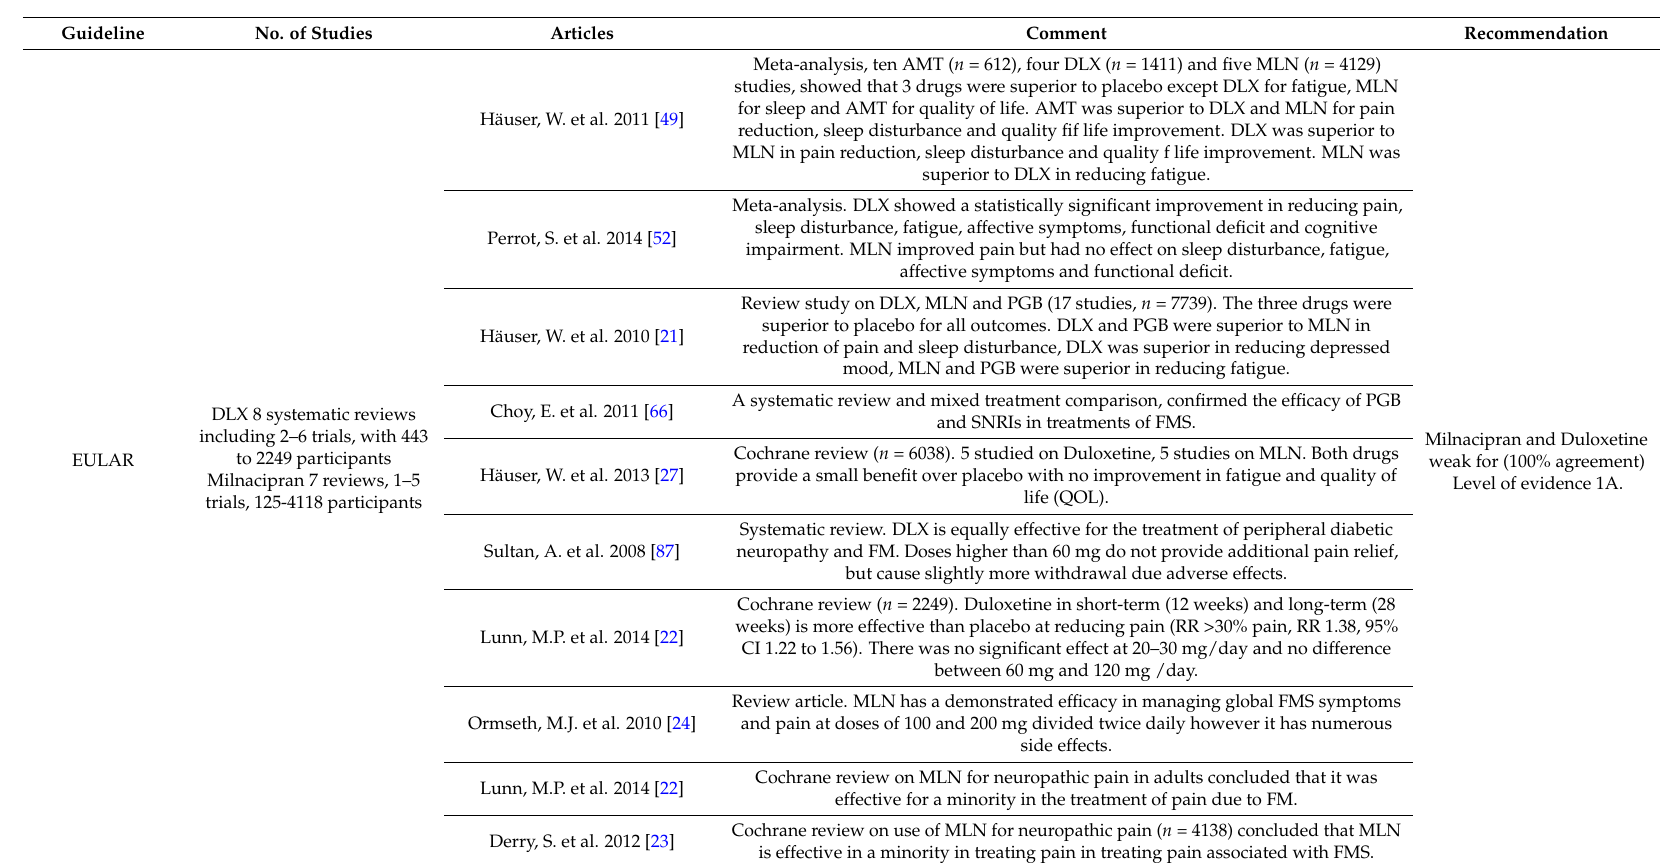
Table A5. Norepinephrine-Selective Reuptake Inhibitors